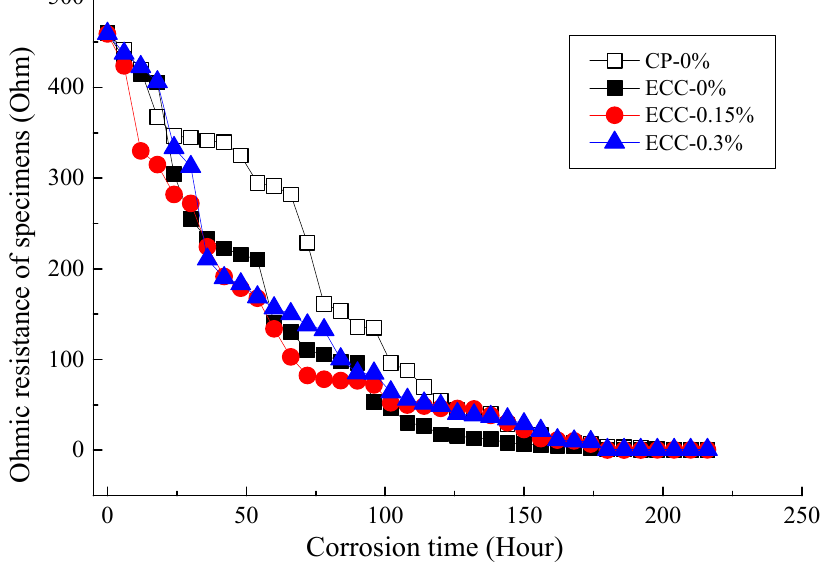
Figure 10. Ohmic resistance of specimens versus exposure time for the CP and ECC grouts.